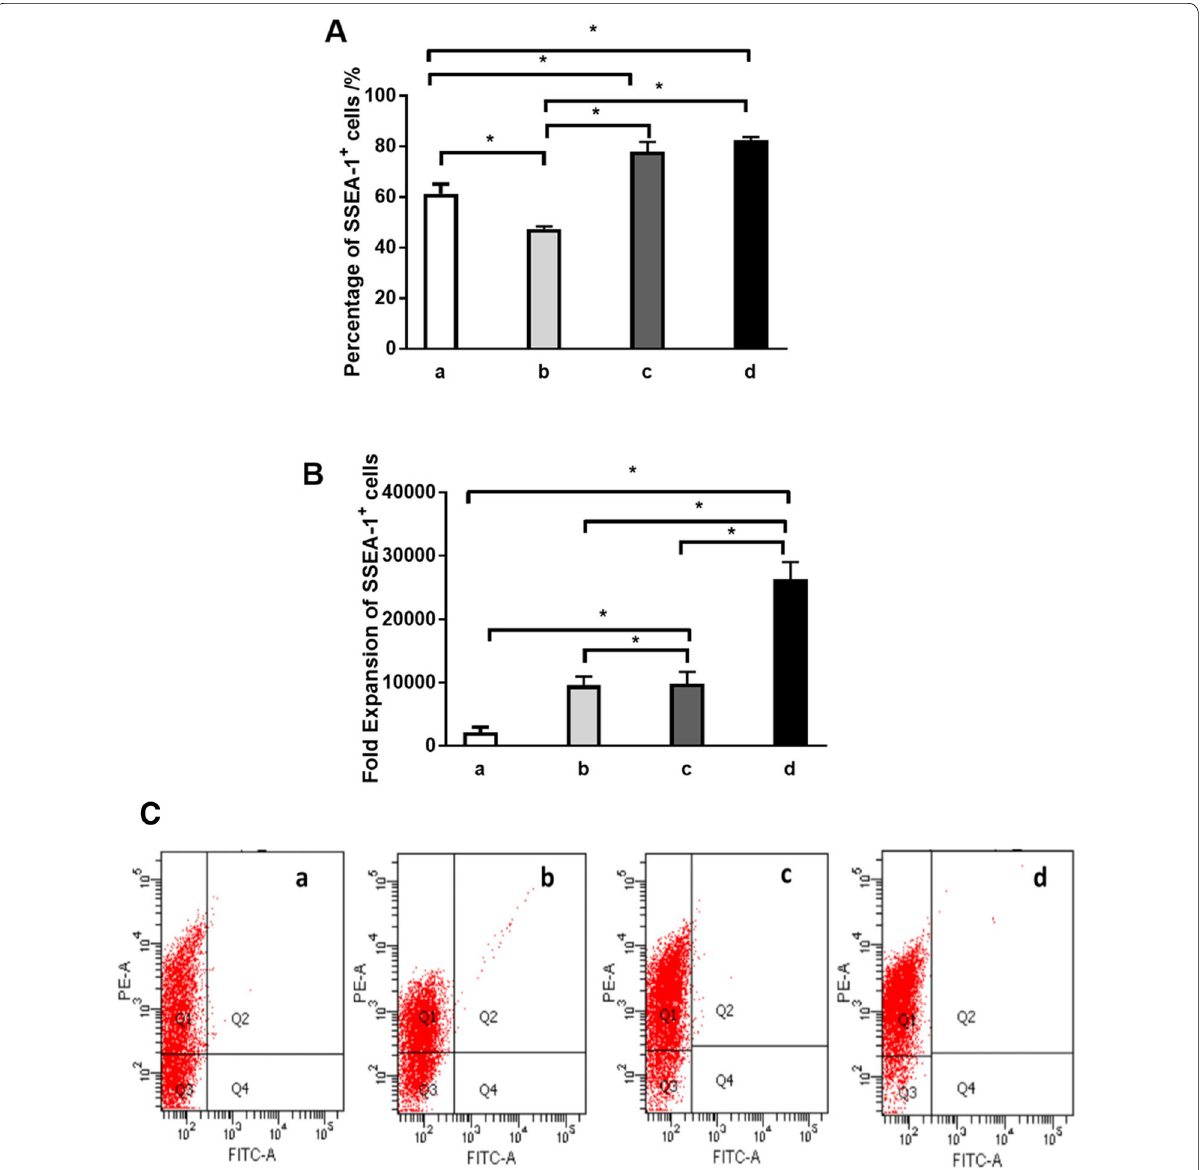
Fig. 5 Synergism of FGF/MEK/ERK signaling and Wnt/β‑catenin signaling in maintaining mESC pluripotency. The concentration of SB216763, SU5402 and PD0325901 used here was 5 μM, 2 μM and 1 μM. A The percentage of SSEA‑1 + cells after three passages. B Fold expansion of SSEA‑1 + cells after three passages. C Signal threshold for SSEA‑1 + cell in flow cytometry. Group a (no treatment), Group b (SB216763), Group c (PD0325901 SU5402), Group d (PD0325901 SU5402 SB216763). Error bars are standard deviations ( n + + + ( P <